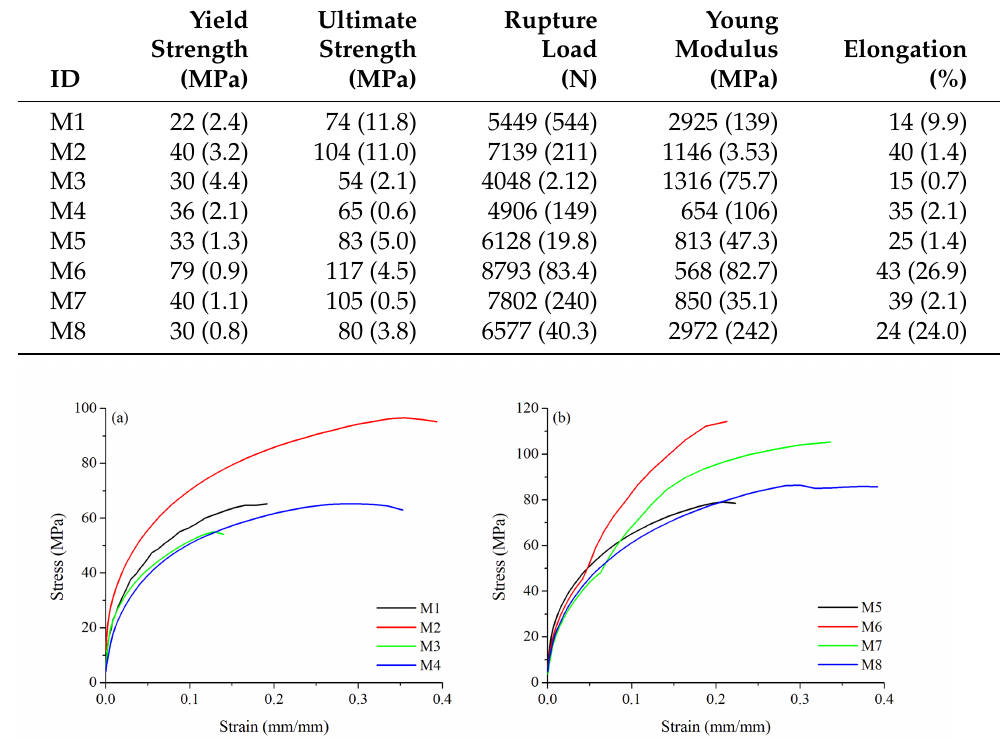
Figure 6. Tensile test curves for AA6061–T6 alloy ( a ), and AA6061–T4 heat-treated alloy ( b ).